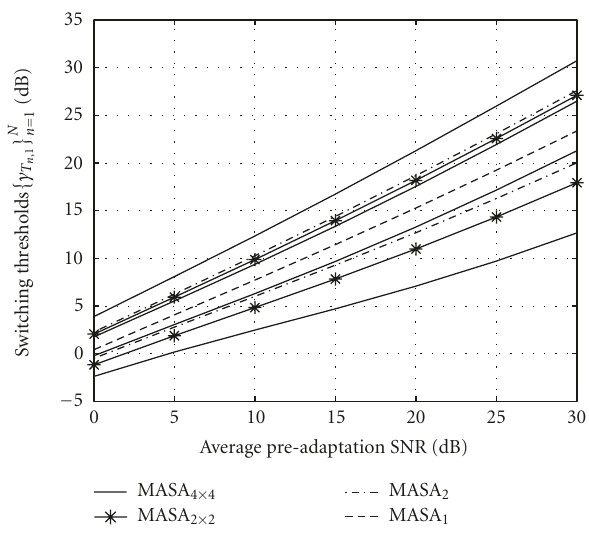
} N as a function of aver- n ,1 n = 1 N ,1